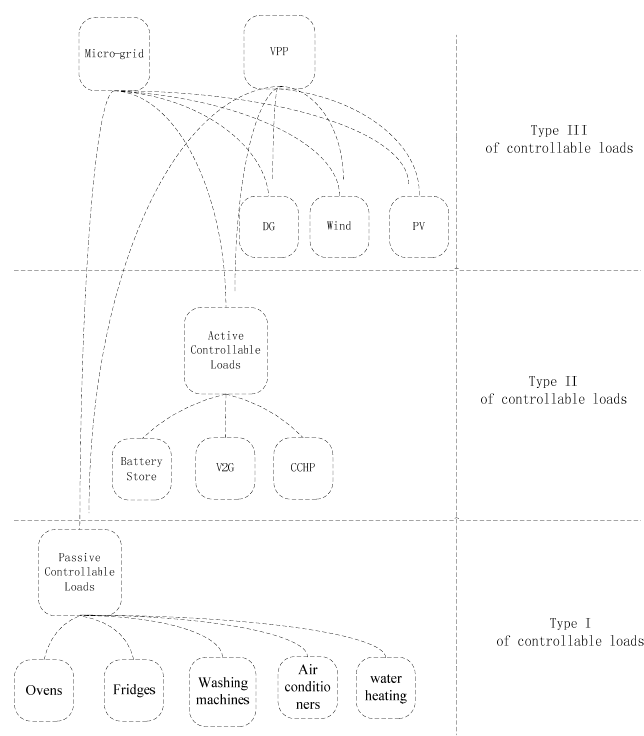
Figure 1. Definition method of controllable